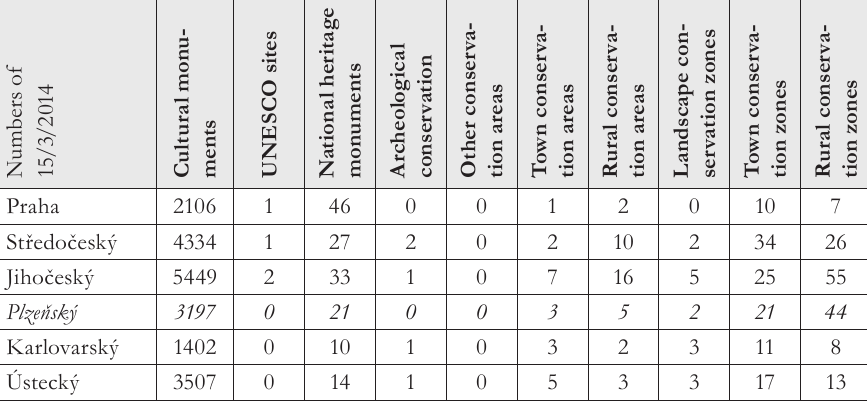
Tab. 1 - Numbers of cultural monuments in regions of the Czech Republic. Source: National Heritage Institute